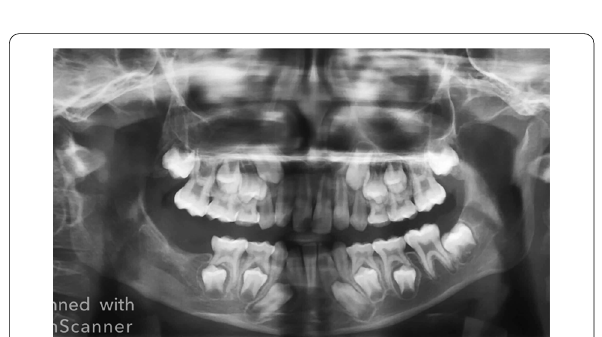
Fig.7 OPG showing evidence of bone formation in the right posterior mandible region at one year